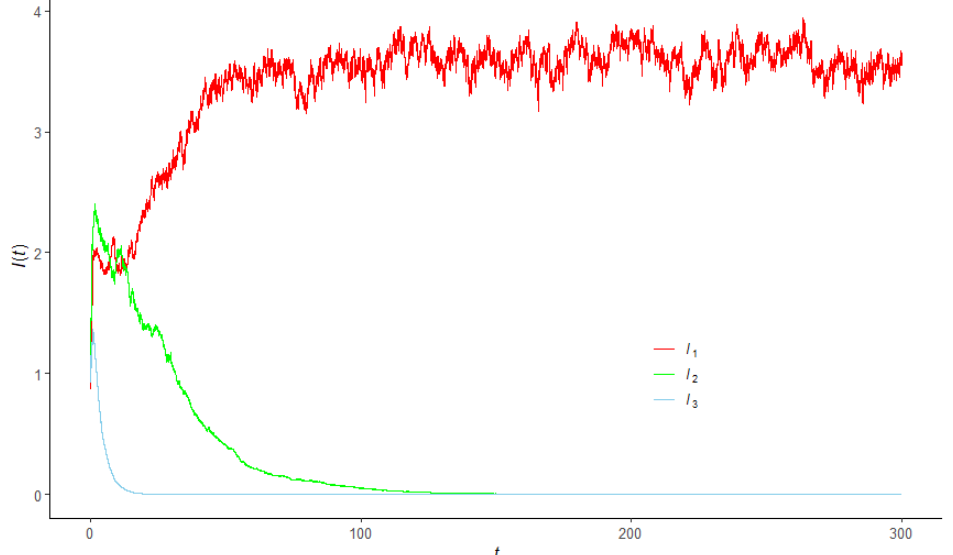
Figure 4. The simulated numbers of infected individuals under condition (b) of Theorem 2.